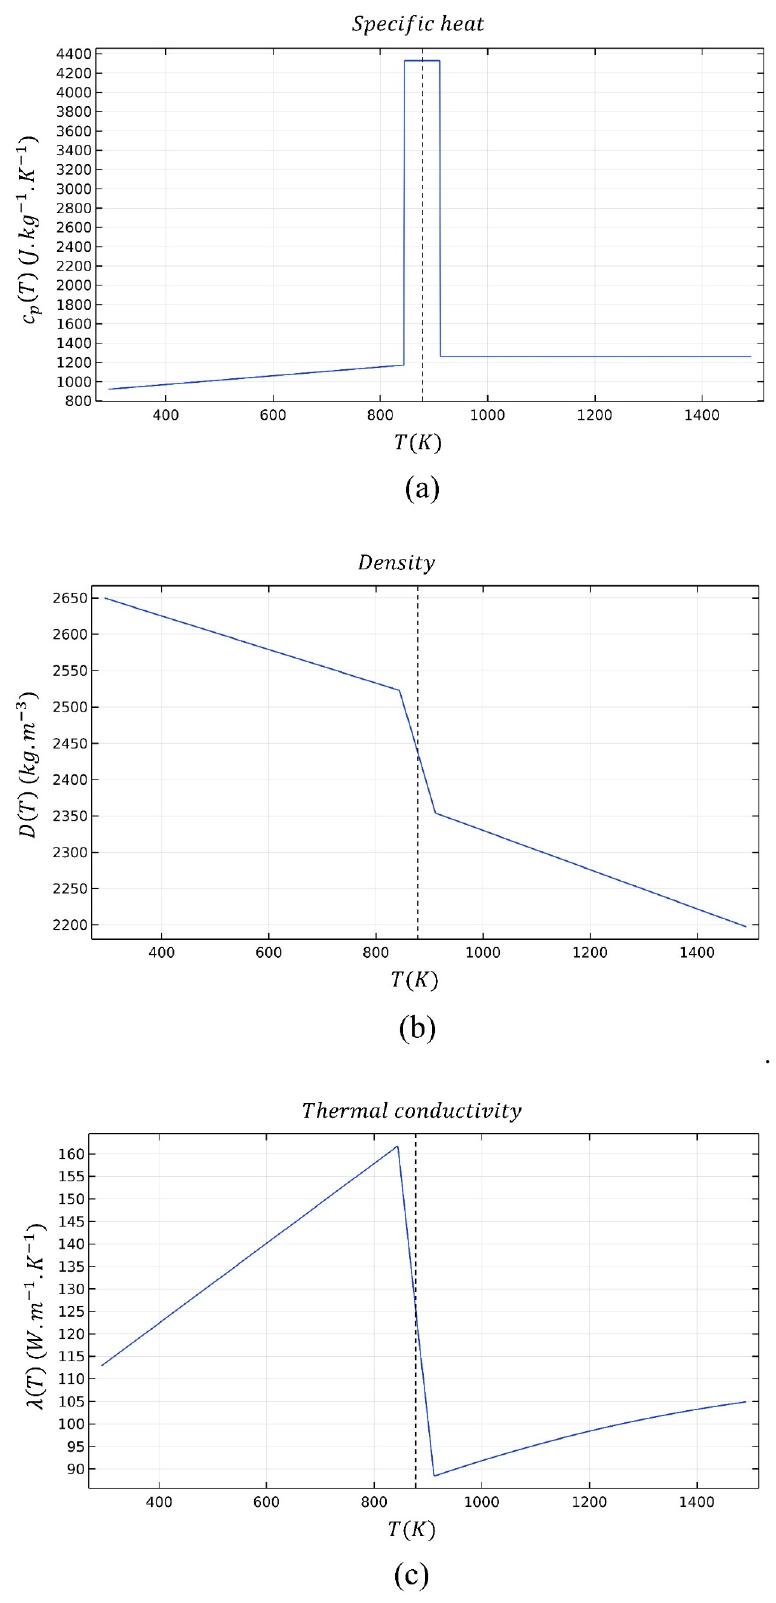
Figure 1. Variation of thermophysical properties for 5456 aluminum alloy (AA5456 with temperature: ( a ) specific heat; ( b ) density; and ( c ) thermal